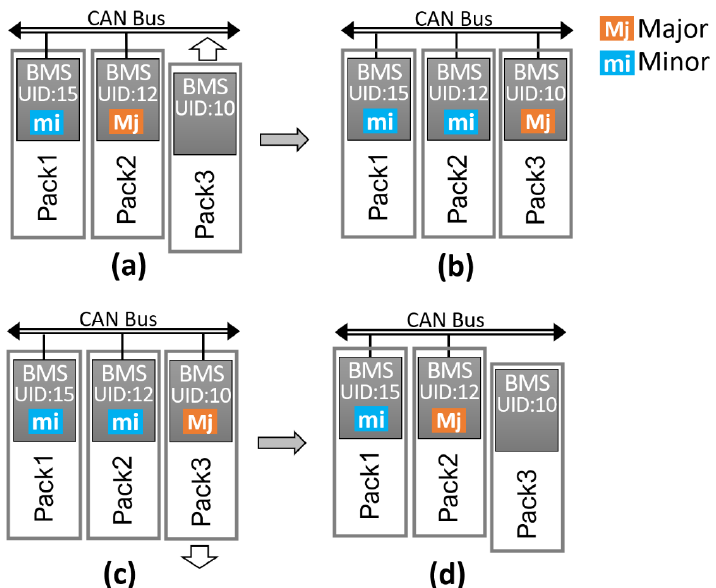
Figure 2. Example event sequences describing how the major SRB pack is determined: ( a , b ) show the newly added pack assuming the role of major, and ( c , d ) demonstrate that after the major SRB pack is removed, the SRB with the lowest UID number assumes the role of major.